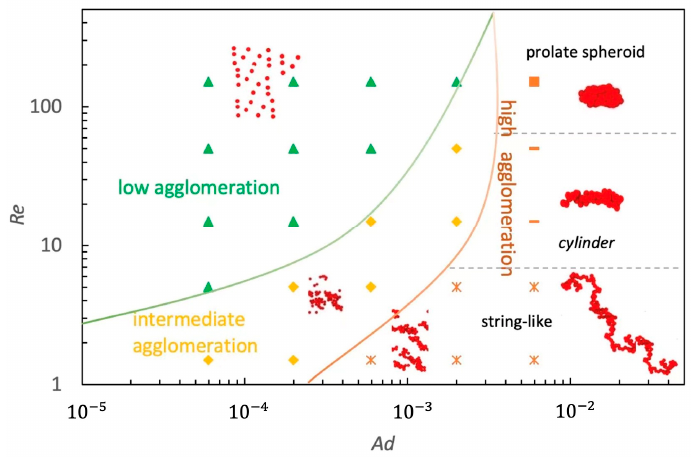
Figure 4. Agglomeration regime map. Phase diagram illustrating the observed cases as a function of the Reynolds and adhesion numbers at a solid particle volume fraction 4.2%.